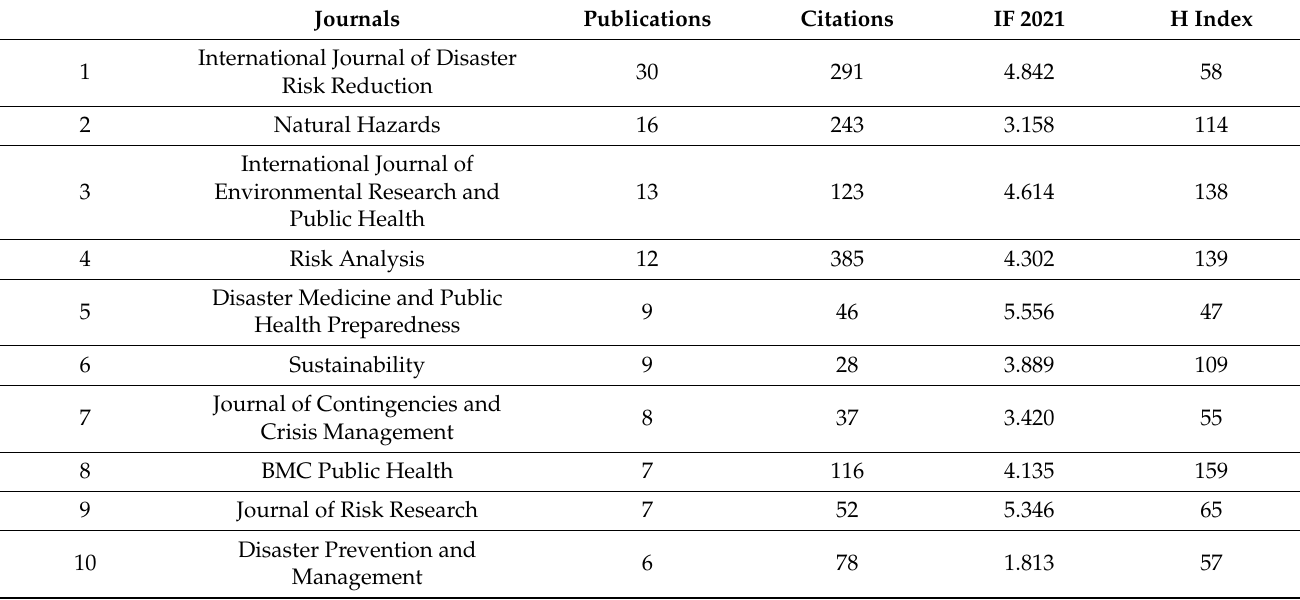
Table 1. Journal distribution (TOP